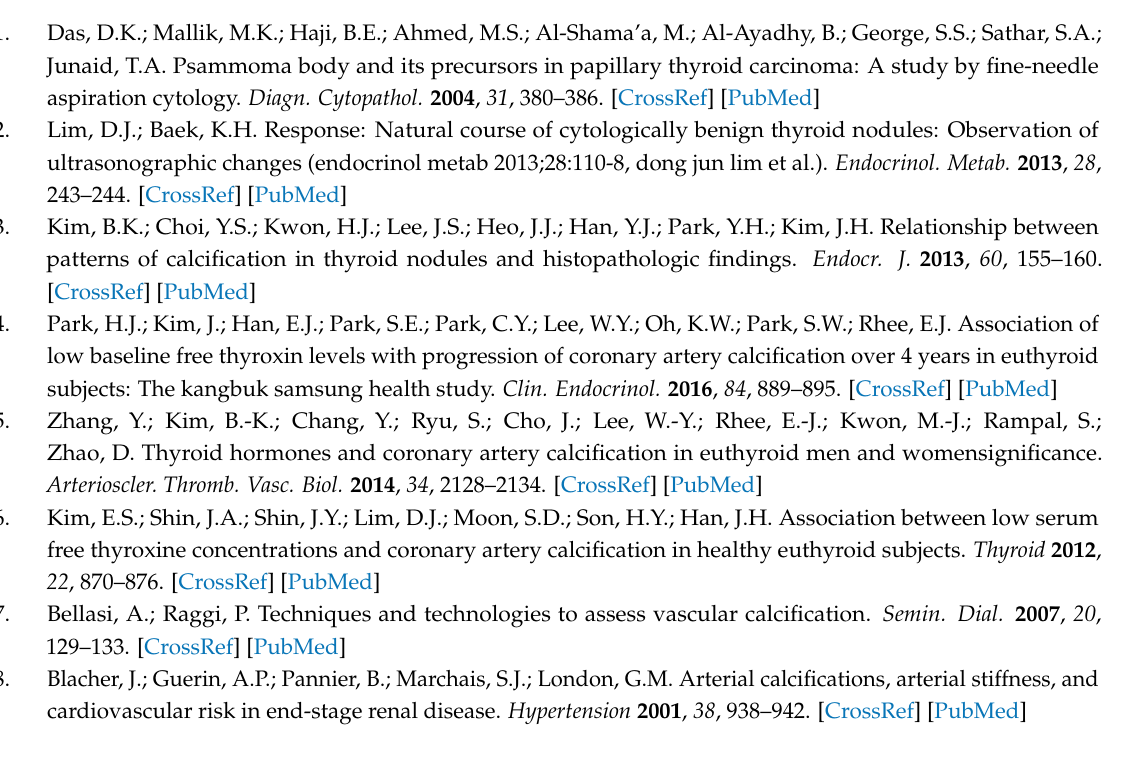
Figure S1: Flow chart for study population enrollment. (A) Group for observing the association of calcification in PTC and coronary artery calcification (Group 1), (B) Group for observing the association of calcification pattern in PTC according to thyroid hormones (Group 2), Figure S2: A schematic diagram of the study hypothesis. The solid lines indicate knowledge confirmed by several references, and the dotted lines indicate the hypothesis tested in this study. The mechanism for the relationships has not been clarified, even for information confirmed by published